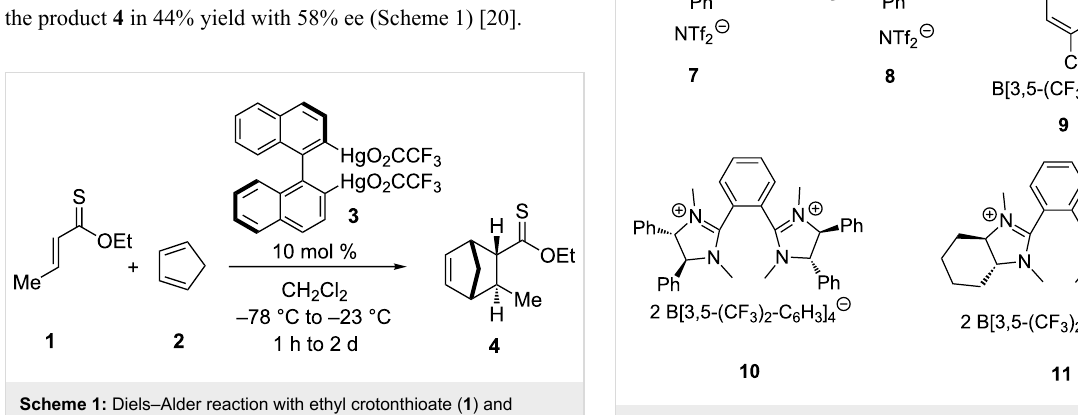
Scheme 2: Diels–Alder reaction catalysed with imidazolinium